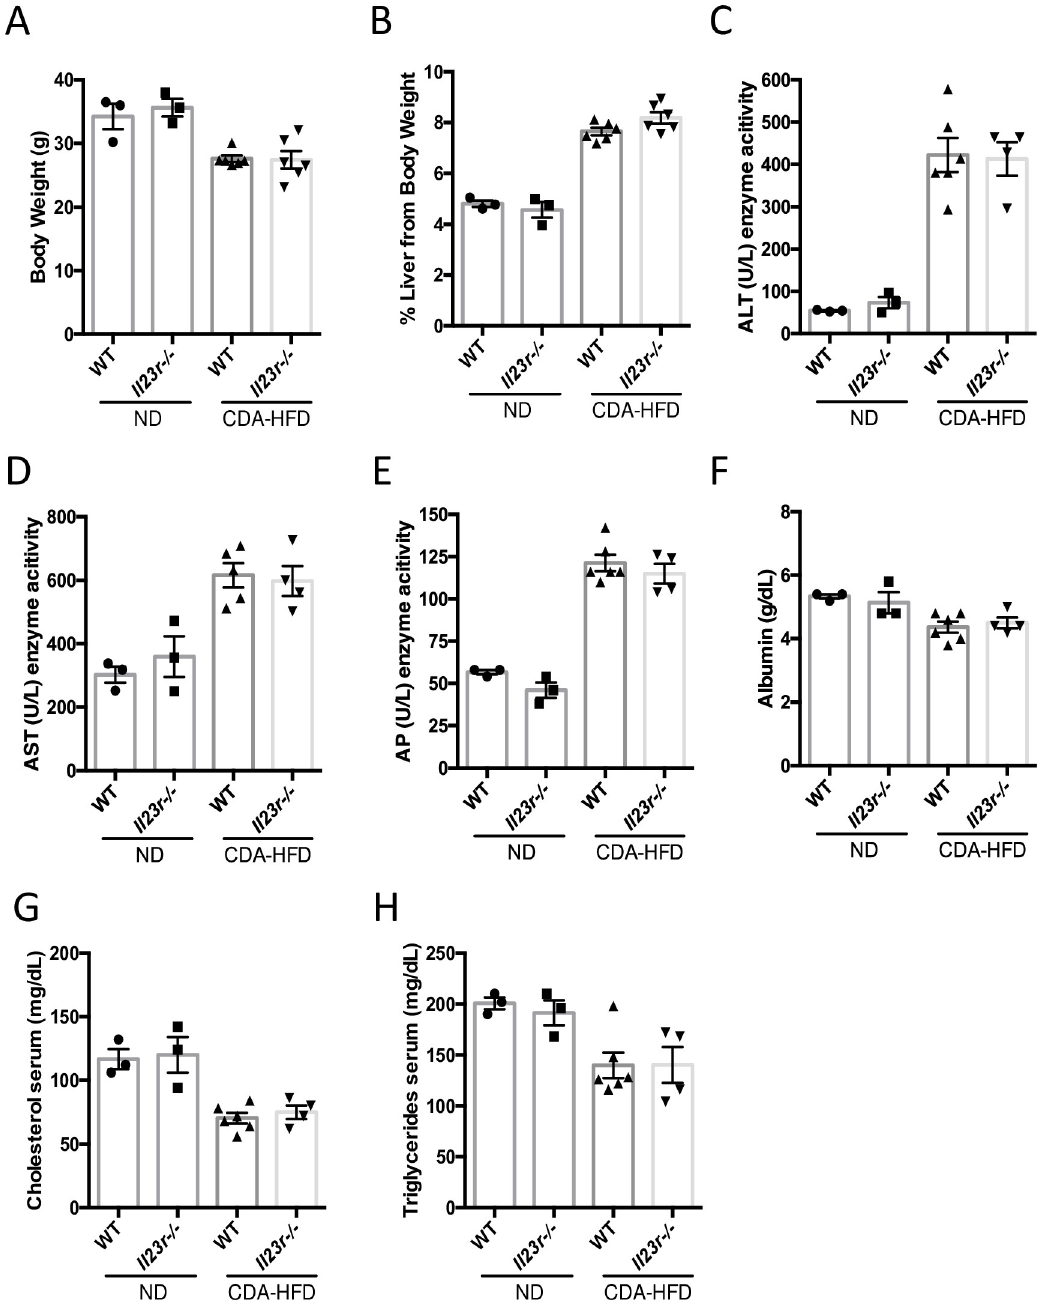
Fig 7. IL-23 signaling does not contribute to CDA-HFD-induced liver dysfunction. Body weights in gram (g) (A) and percent liver weights from body weight (B). Quantification of serum liver enzymes for Alanine Aminotransferase (ALT) (C), Aspartate Aminotransferase (AST) (D), and Alkaline Phosphatase (AP) (E) measured. Serum Albumin protein (F), serum cholesterol (G) and serum triglycerides (H) quantified. Groups: ND WT n = 3, ND Il23r -/- n = 3, CDA-HFD WT n = 6, CDA-HFD Il23r -/- n = 6. Data represents mean ±